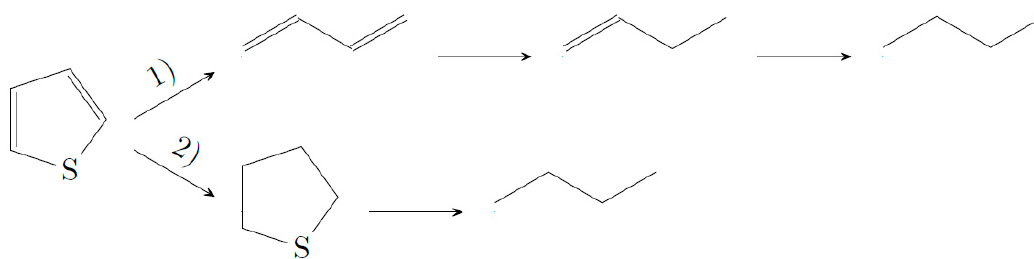
Figure 5. Reaction scheme for the possible pathways of the hydrodesulfurization (HDS) of thiophene with platinum group metal (PMG) phosphides [29].